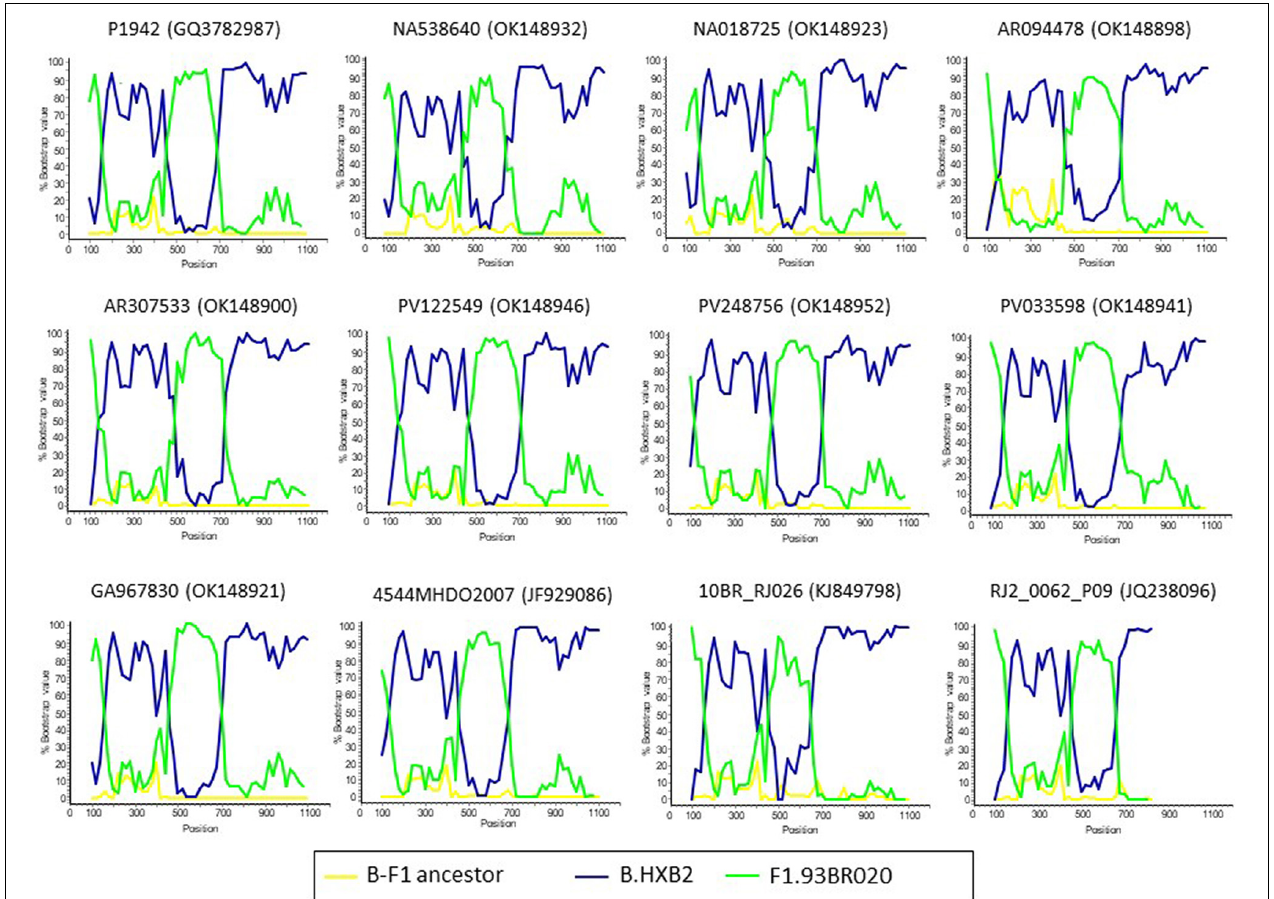
FIGURE 3 | Bootscan analyses of PR-RT sequences of CRF47_BF viruses. Simplot v3.5 (Lole et al., 1999) was used for the analyses. Twelve representative profiles are displayed. Names of viruses, with GenBank accessions, are shown above each bootscan plot. P1942 was included as CRF47_BF reference. A reconstructed B-F1 ancestral sequence was used as outgroup. The horizontal axis represents the position from nucleotide 1 of protease and the vertical axis represents bootstrap values supporting clustering with references.